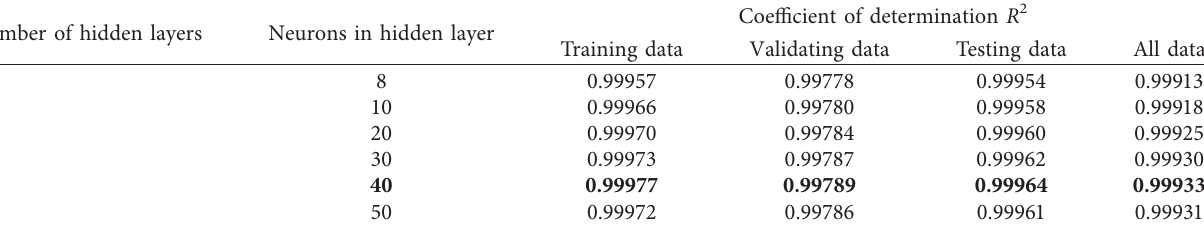
Table 6: Determination coefficient R 2 for different learning algorithms to predict deflection for Scheme C. Number of hidden layers